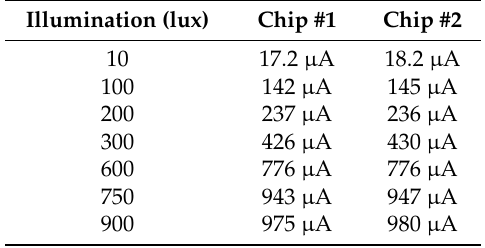
Table 5. Measured output currents with respect to illumination with R SS of 1 k Ω for the proposed CAs.